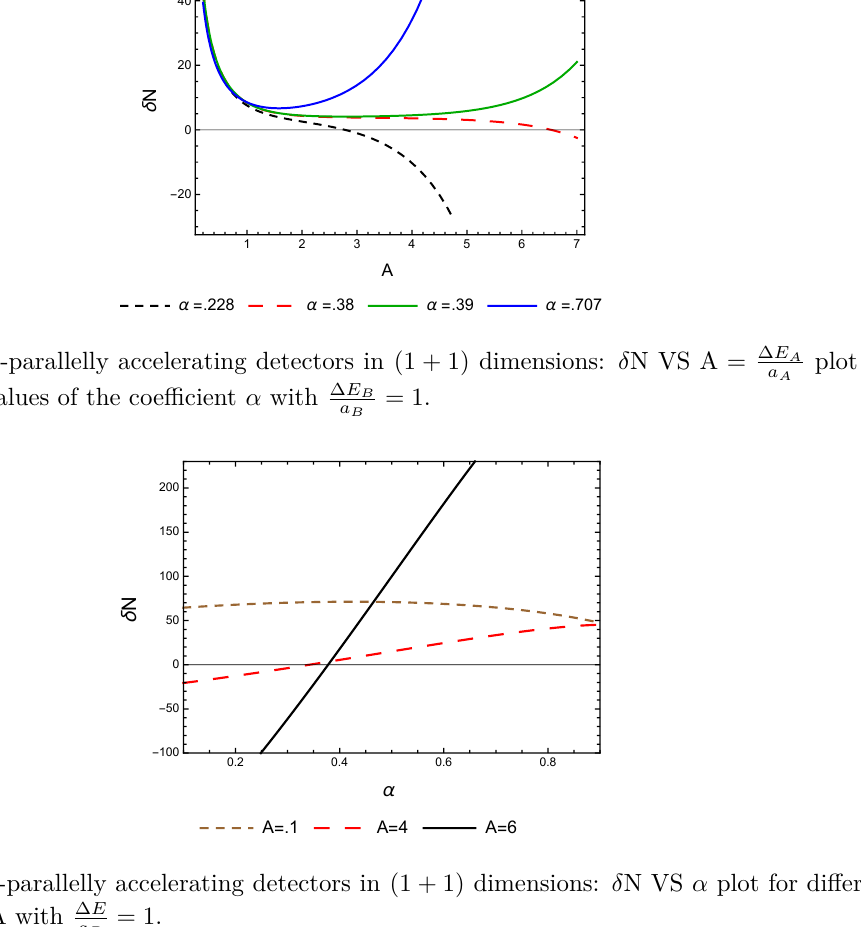
Figure 5 . Anti-parallelly accelerating detectors in (1 + 1) dimensions: δ N VS α plot for different fixed values of A with ∆ E = 1 a B